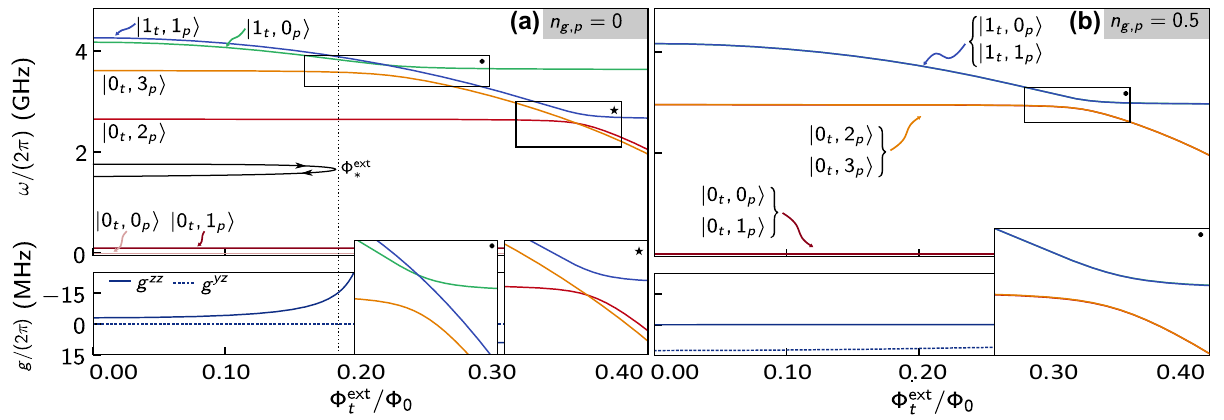
(cid:3) (cid:3) (cid:4) (cid:4) (cid:3) (cid:3) ↔ 0 t , 3 p anticrossing at 1 t , 0 p